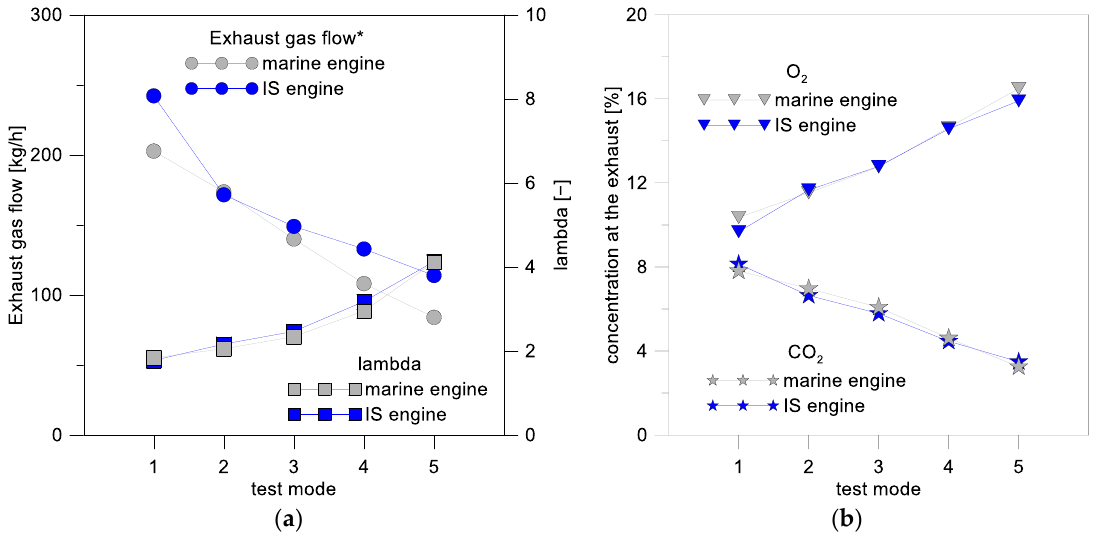
Figure 8. Comparison of ( a ) exhaust flow rate and lambda value and ( b ) O 2 and CO 2 emissions, between marine and intermediate-scale engine in the five selected modes. * Note: for the marine engine, the gas flow is scaled 1:20.